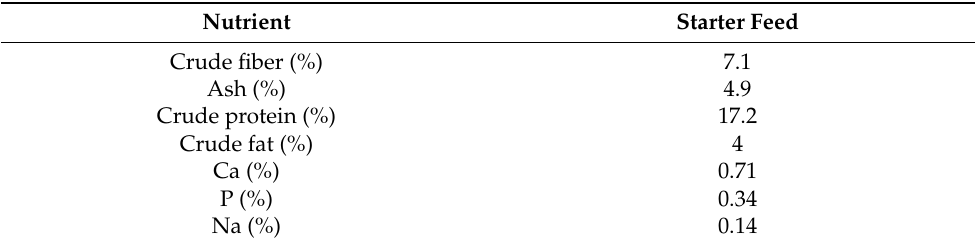
Table 1. Diet composition (percentage of dry matter) provided to all steers in the study during the weaning